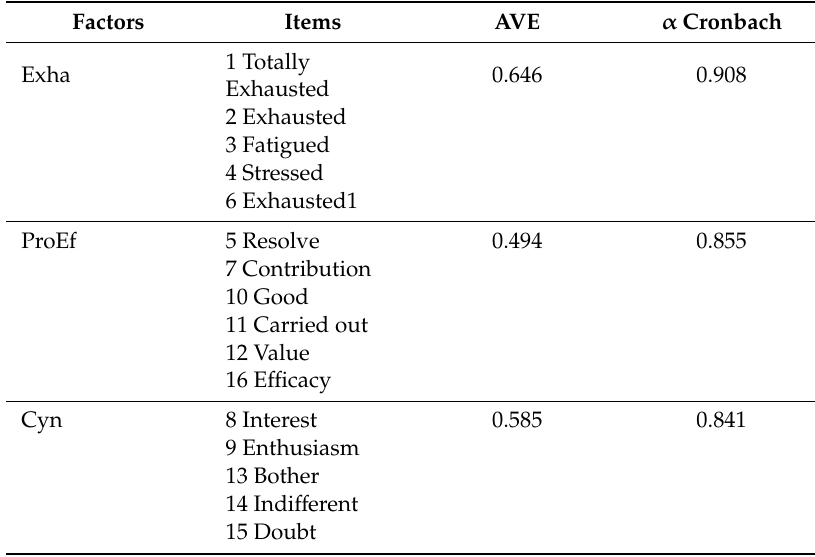
Table 4. Average Variance Extracted and α Cronbach by